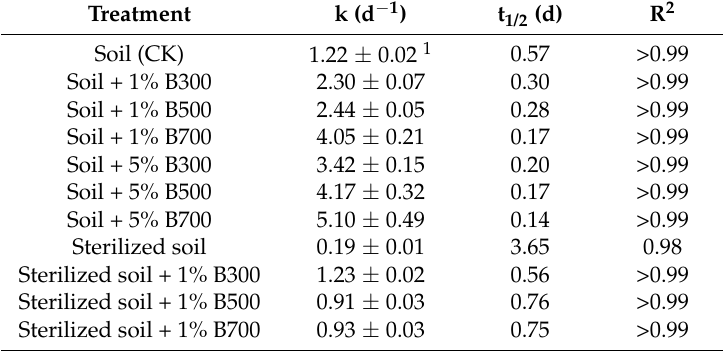
Table 5. Fitting results of CP degradation in different biochar-amended soils using a first-order model.